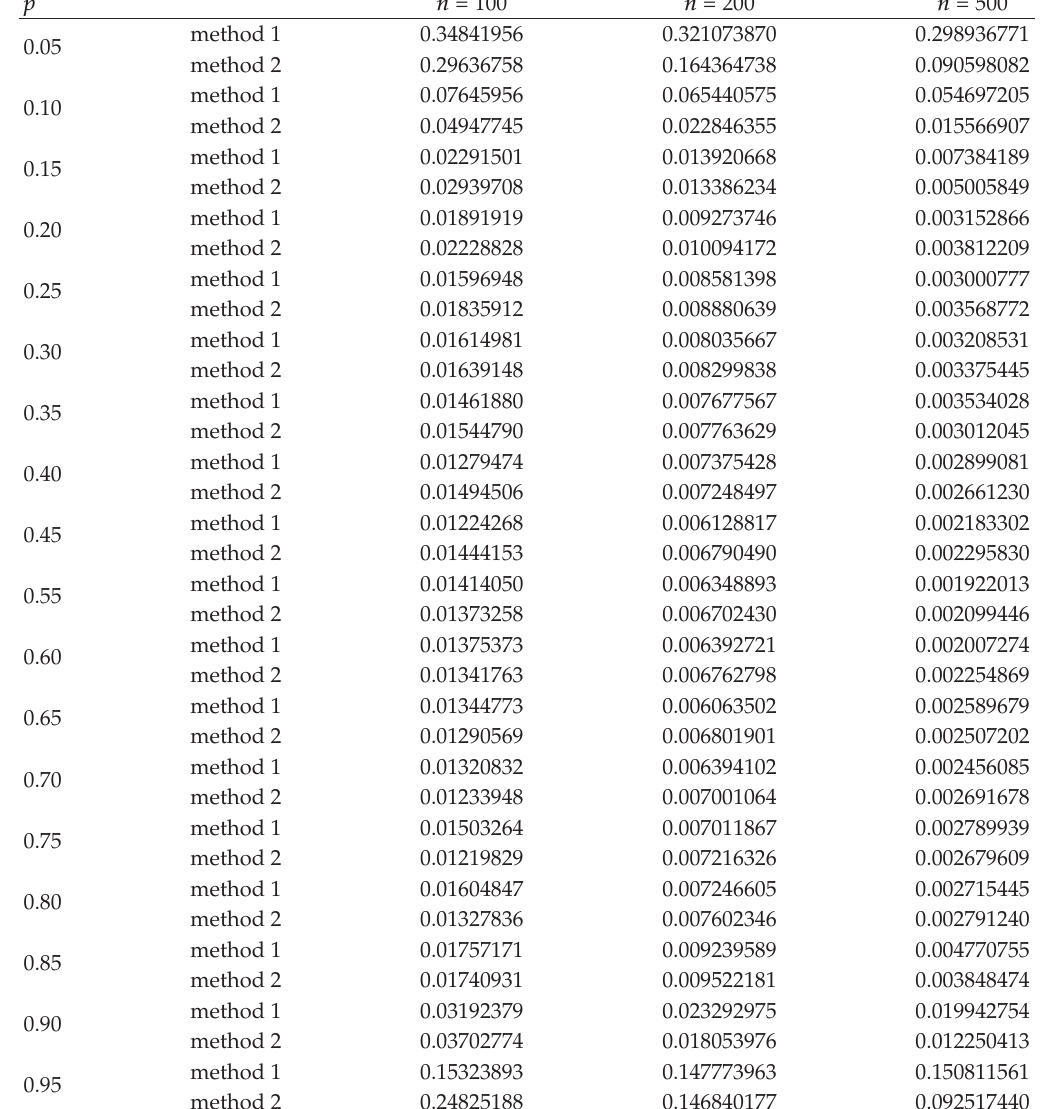
Table 1: Mean squared errors results for bandwidth selection methods for di ff erent sample sizes and for data from a normal